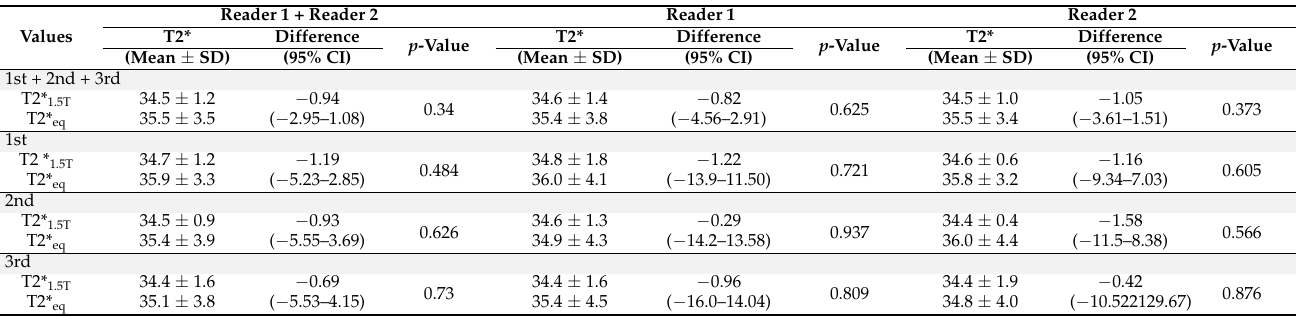
Table 4. Comparison of T2* measured in 1.5T (T2* 1.5T ) and equivalent T2* values from 3.0T (T2* eq ) in normal